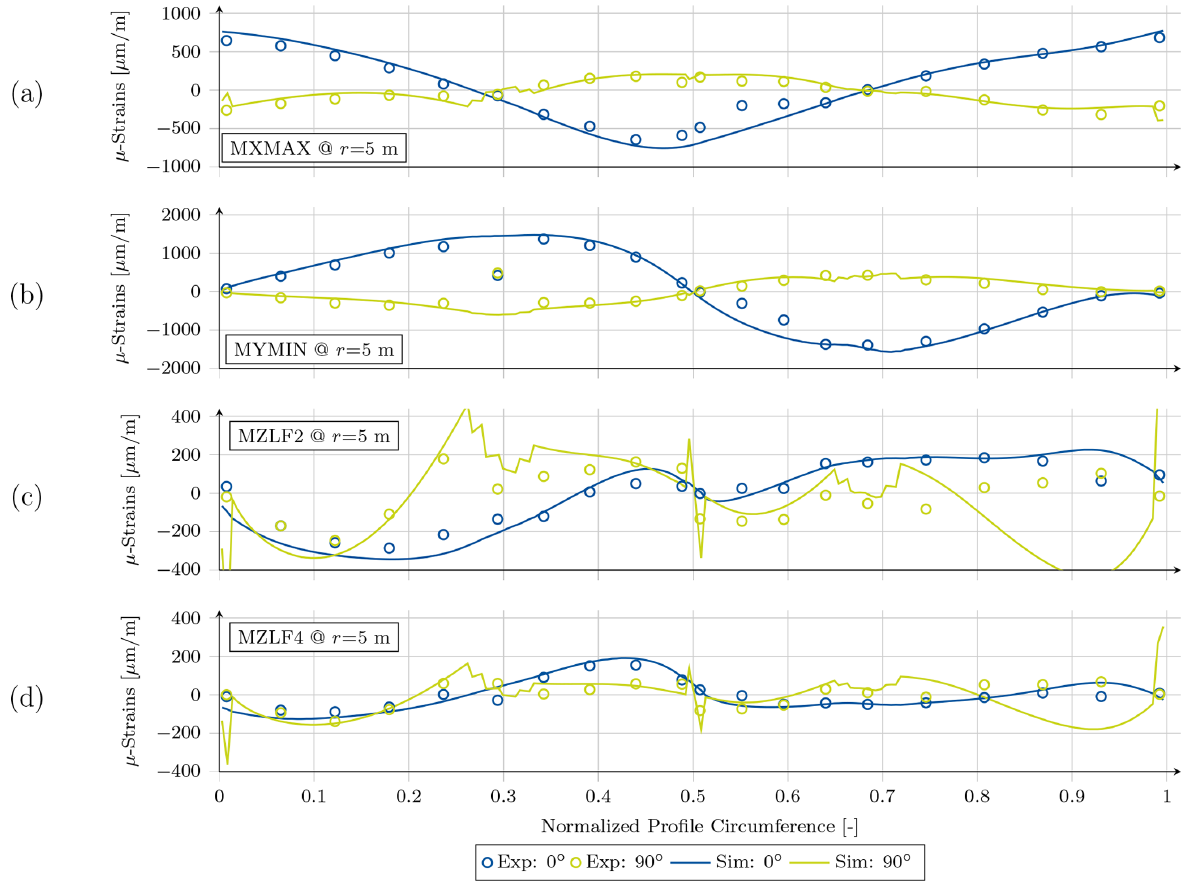
Figure B2. Spanwise and crosswise strains of the simulation and the test, plotted against the normalized profile circumference of the cross section at r = 5m for the (a) MXMAX, (b) MYMIN, (c) MZLF2, and (d) MZLF4 load case.